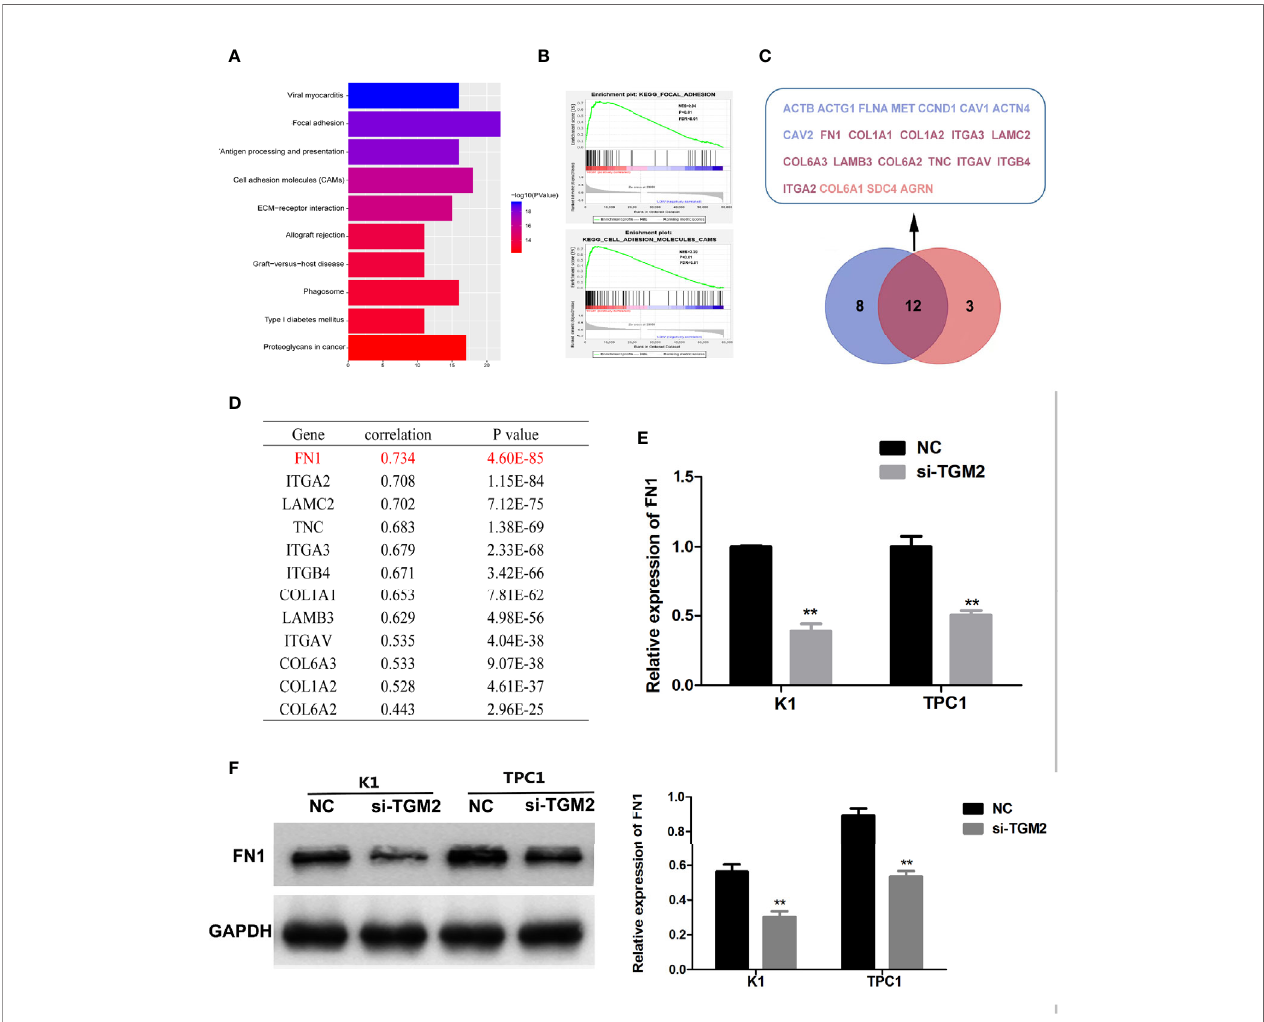
FIGURE 6 | Bioinformatic analysis showing that FN1 is a target of TGM2 in PTC. (A) KEGG analysis of the top 200 differentially upregulated genes in TGM2 high- expression tumors. (B) GSEA highlighting the positive association of upregulated TGM2 expression levels with Focal adherence and Cell adhesion molecules. (C) Venn diagram analysis of the co-expressed genes in the set Focal adherence and Cell adhesion molecules. (D) Pearson ’ s correlation was performed to analyze the correlations between TGM2 and co-expressed genes in the set Focal adherence and Cell adhesion molecules. (E) The relative mRNA expression of FN1 was detected using qRT-PCR in PTC cells after transfection with si-TGM2 or NC. Data are presented as the mean ± S.D., as analyzed using an independent samples t-test. **P < 0.01 versus NC. (F) Western blotting was applied to detect the protein level of FN1 in PTC cells transfected with si-TGM2 or NC. Data are presented as the mean ± S.D., as analyzed using an independent samples t-test. **P < 0.01 versus